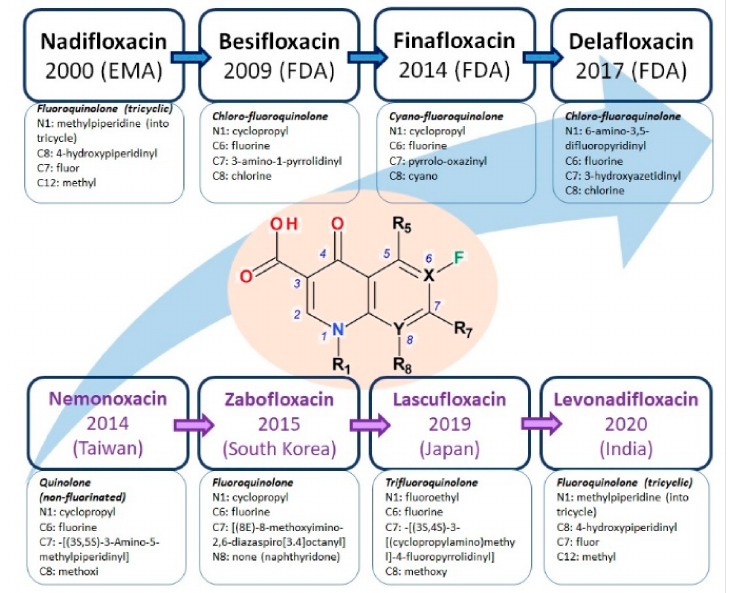
Figure 3. New FQNs chronology in therapy (since 2000) and essential structural characteristics. The newest antibacterial 1,4-QNs used in therapy have diverse structural character- istics (Figure 4). According to the chemical structure of the base nucleus, these new com- pounds have a QN nucleus (besifloxacin, delafloxacin, finafloxacin, and nemonoxacin), a tri- cyclic ring including a QN nucleus (nadifloxacin), and naphthyridine nucleus (zabofloxacin). Regarding the presence of halogen atoms in the chemical structure, these compounds con- tain one fluorine atom (nadifloxacin and levonadifloxacin, finafloxacin, and zabofloxacin), one fluorine and one chlorine atom (besifloxacin), three fluorine atoms (lascufloxacin), three fluorine and one chlorine atoms (delafloxacin), but there is also an exception without any halogen atom (nemonoxacin).